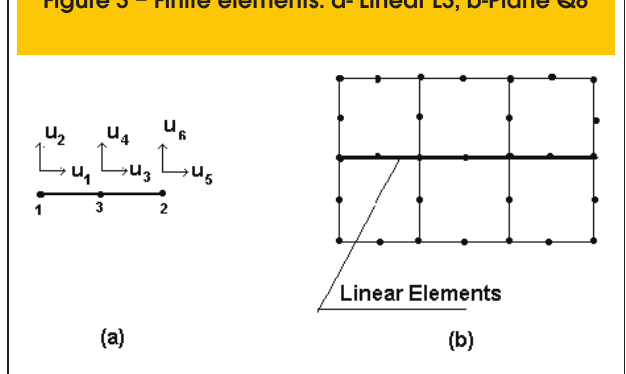
Figure 3 – Finite elements: a- Linear L3; b-Plane Q8